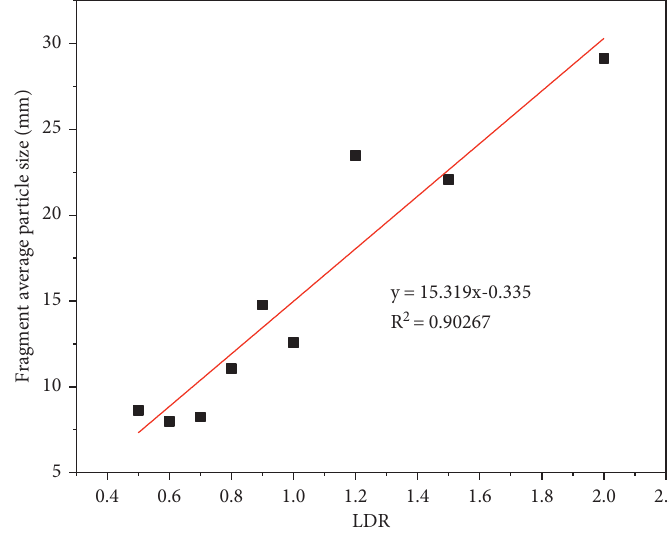
Figure 7: Correlation between specimen length-to-diameter ratios and average specimen fragmentation.